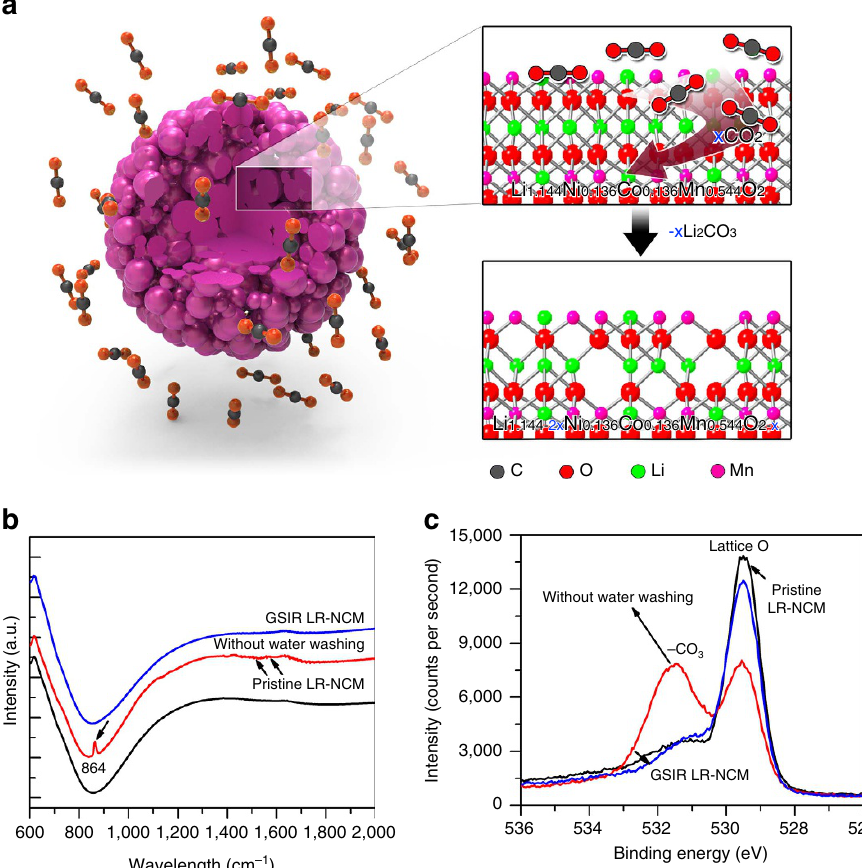
Figure 1 | GSIR. ( a ) Schematic of GSIR between Li-rich layered oxides and carbon dioxide. ( b ) FTIR spectrum. The GSIR LR-NCM without water washing (red line), compared with the pristine LR-NCM, has three additional peaks, corresponding to the IR-active modes of –CO 3 . The sharp peak (864cm (cid:2) 1 ) is the CO 3 group bending mode, while the other two peaks (1,438 and 1,500cm (cid:2) 1 ) are from the C–O asymmetric and symmetric stretching modes; ( c ) XPS spectra of the O 1s. It is clear that the GSIR LR-NCM has lower intensity than that of the pristine LR-NCM at lower-banding energy, which indicates some lattice O has been extracted by CO 2